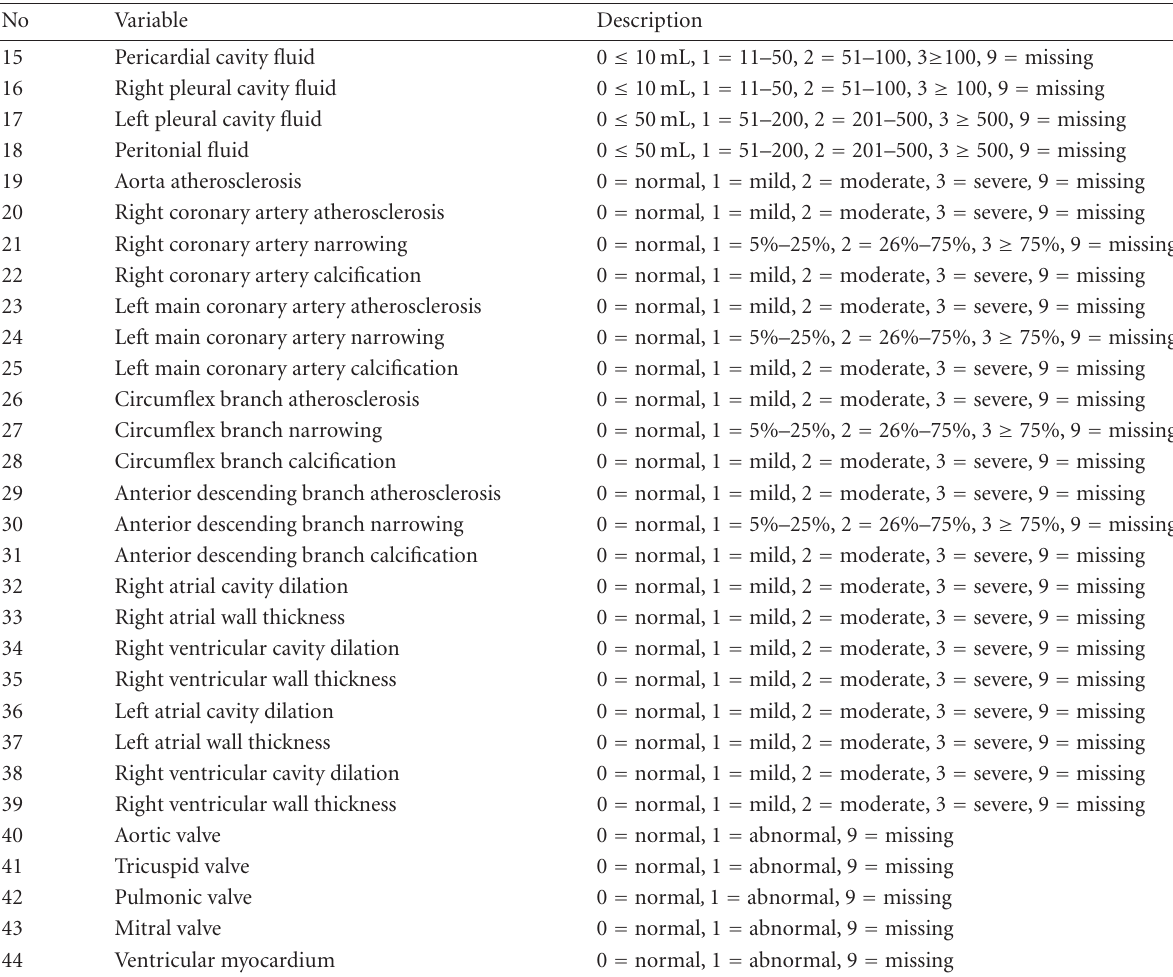
Table 2. The cardiovascular variables.